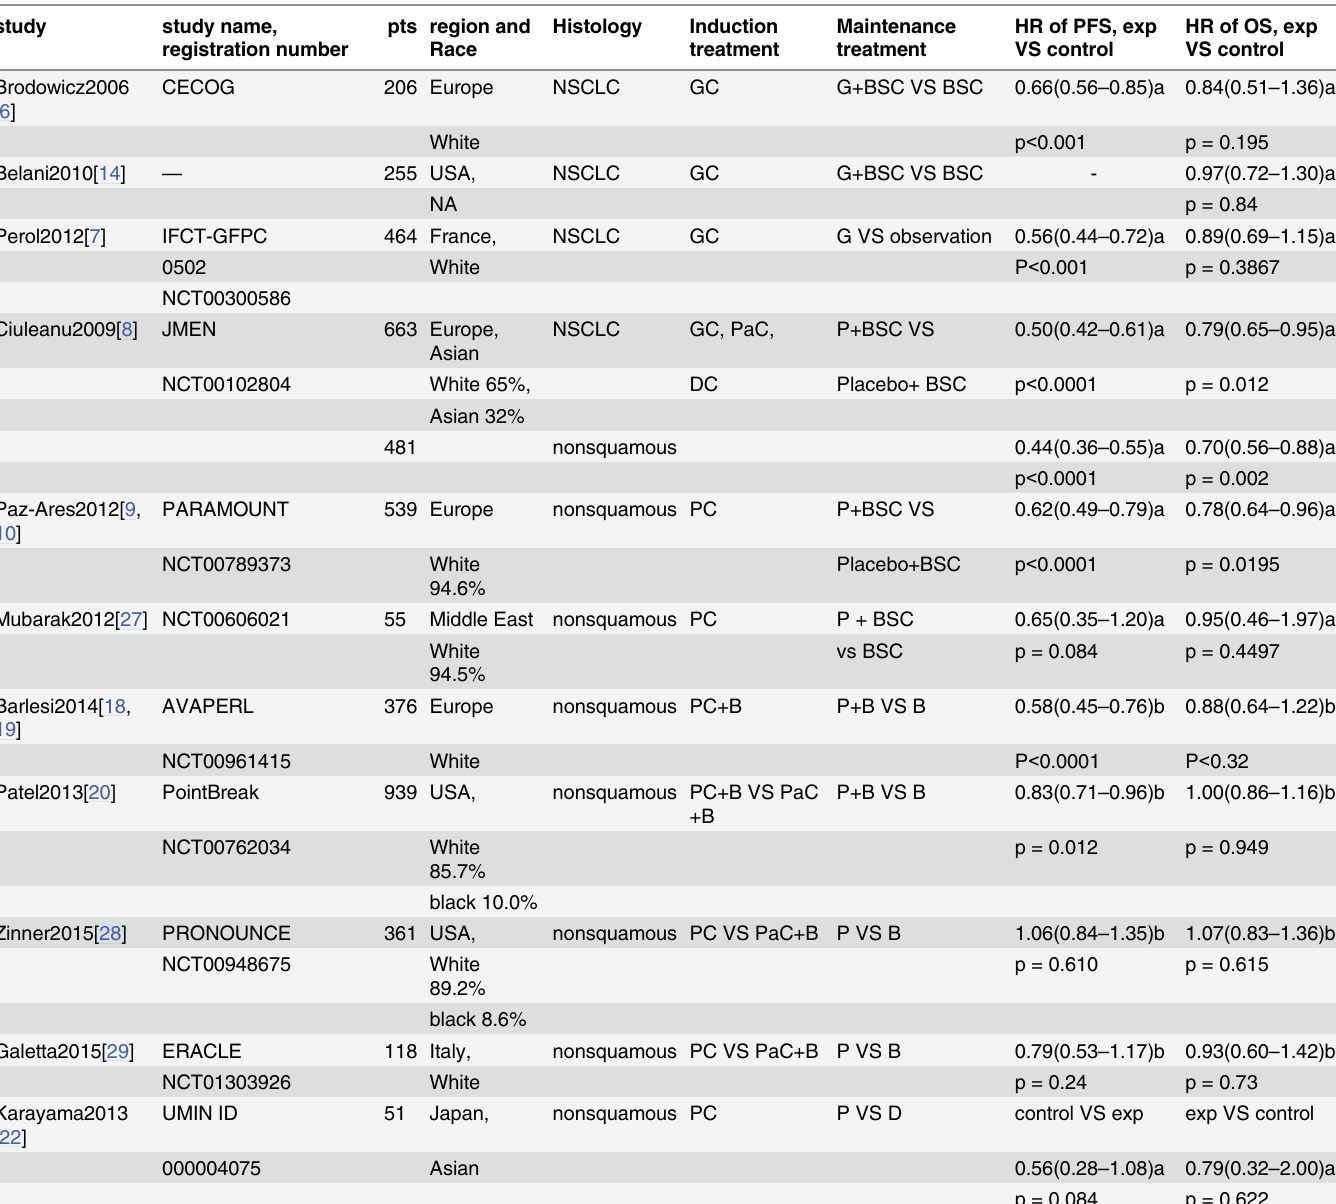
Table 1. Main characteristics of the